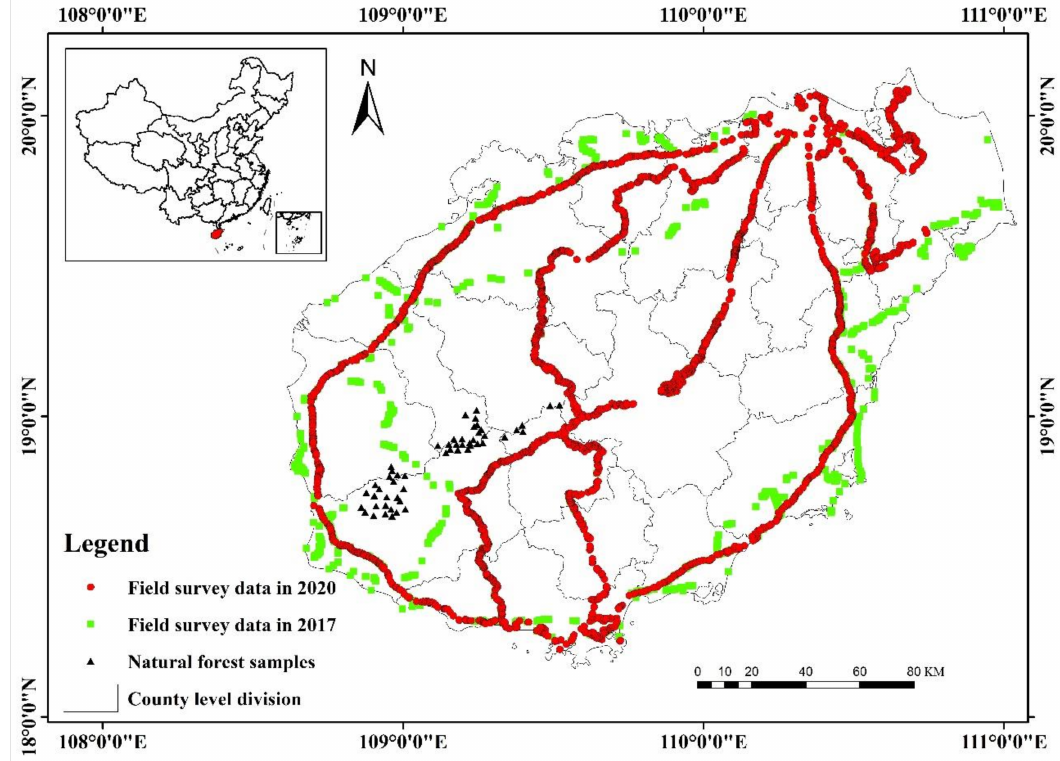
Figure 1. Location of Hainan Province in China and field